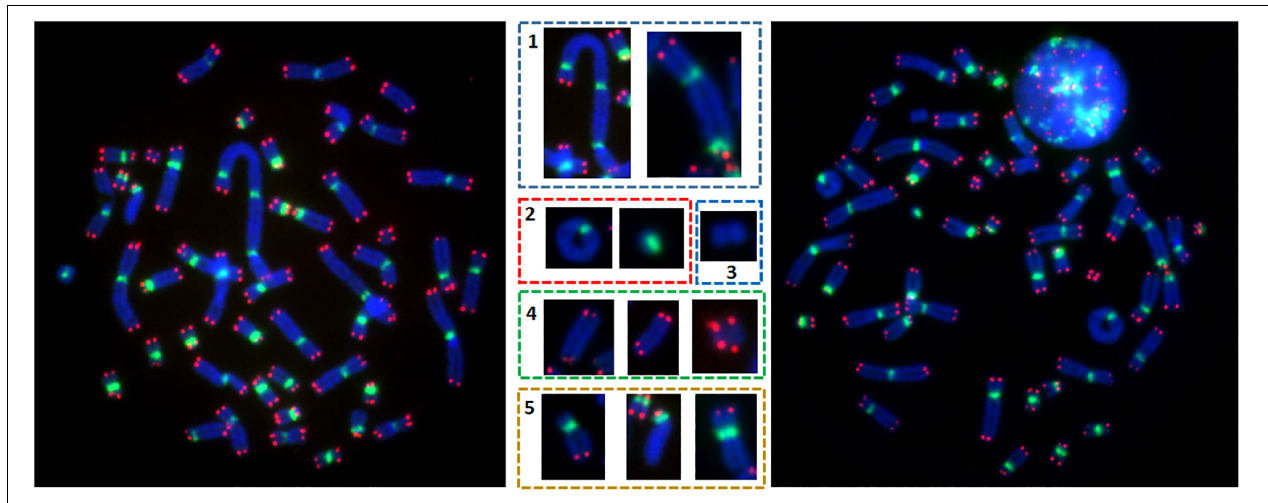
FIGURE 1 | Metaphases after telomere (red) and centromere (green) staining permit precise detection of unstable chromosomal aberrations e.g., the presence of (1) dicentric chromosomes, (2) ring chromosomes, (3) acentric rings, (4) acentric chromosomes with 4 red signals, and (5) telomere